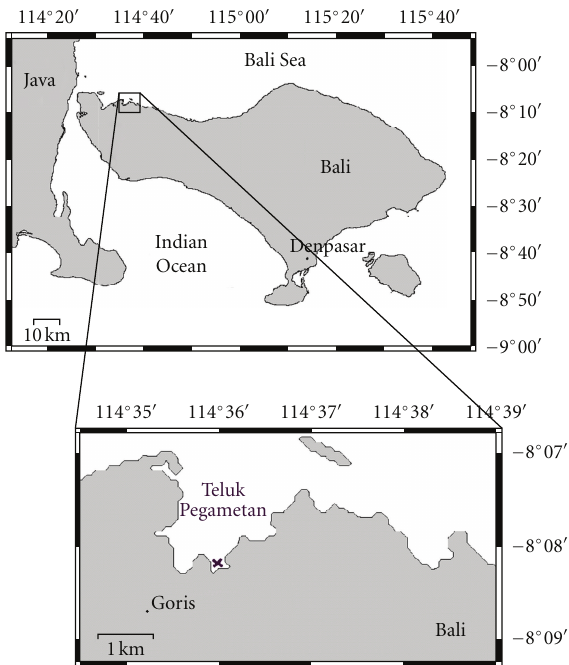
Figure 3: Map of the sampling and study site (X) at Teluk Pegametan, Northern Bali [31].